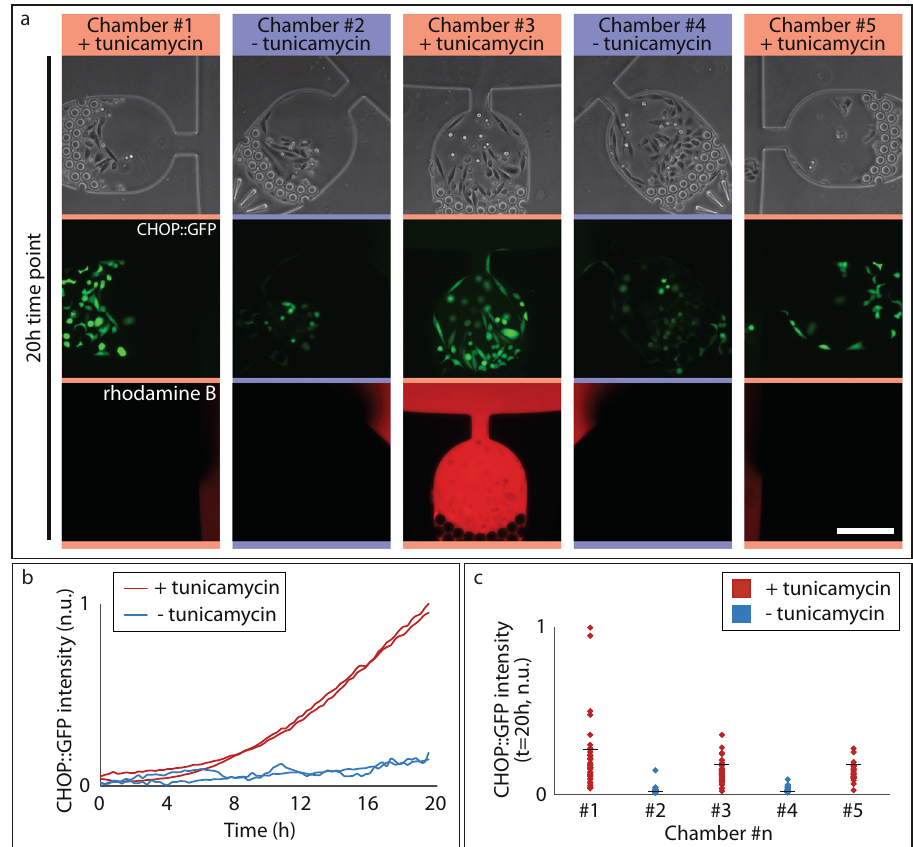
Fig. 2 Live cell imaging on VersaLive. a CHO-K1 cells in the indicated chambers were exposed to tunicamycin treatment (0.5 μ g/mL for 20 h) and the integrated stress response was measured by the intensity of CHOP::GFP fl uorescence. The third row shows rhodamine B that was used as fl ow tracer to check proper fl ow in the platform throughout the time-lapse acquisition. Scale bar, 150 µ m. b Time course of the average CHO::GFP fl uorescence across cells in chambers #1, #2, #3, #4 (15 min time resolution). c Single-cell quanti fi cation of the CHO::GFP fl uorescence of the images reported in a returned a 15-fold difference between the treated and the untreated samples. Dots represents single cells ( n = 38 in #1, n = 28 in #2, n = 49 in #3, n = 55 in #4, n = 24 in #5) while black bars are median Fig. 2a – c, at the end of the treatment, only cells exposed to tunicamycin expressed CHOP::GFP, con fi rming no cross- fl ow among chambers. Moreover, as an additional check for the proper function of the device and the absence of cross- fl ow, we added rhodamine B to the input reservoir of chamber #3. This red fl uorescent dye has no toxic effects on cells. As expected, red fl uorescence was detected only at the outlet of chamber #3 but was absent in the other four chambers. The expression of the CHOP::GFP over time is reported in Fig. 2b and shows appre- ciably higher expression in the treated samples already after 8 h of